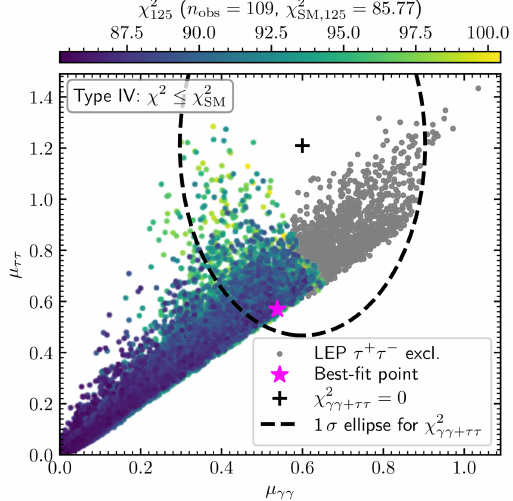
Figure 8 . As in the right plot of figure 1, but those parameter points are shown in grey (plotted below the colored points) that would be excluded by the LEP limit in the τ + τ − final state if that channel had been selected in order to determine the 95% C.L. limit.